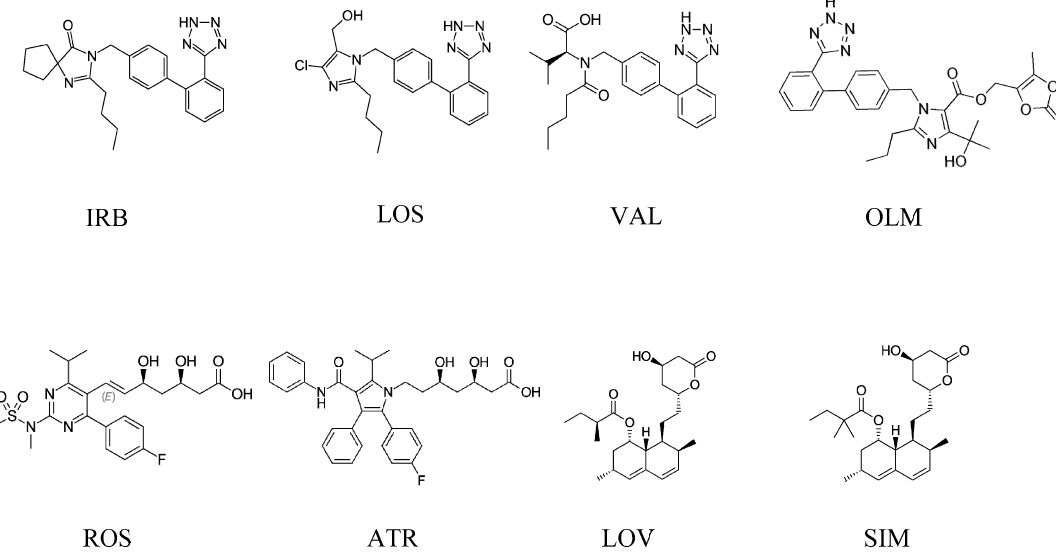
Figure 1. Chemical structures of irbesartan (IRB), losartan (LOS), valsartan (VAL), olmesartan (OLM), rosuvastatin (ROS), atorvastatin (ATR), lovastatin (LOV), and simvastatin (SIM). Du е t о th е imp о rt а nc е о f th е s е drugs in tr еа ting such f а t а l dis еа s е s, it is r е c о mm е nd е d t о